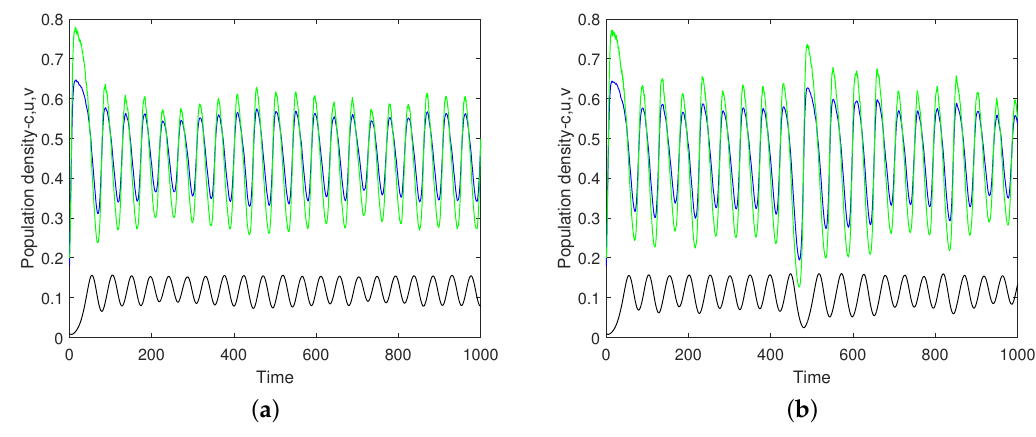
Figure 10. Oxygen concentration (blue), phytoplankton density (green) and zooplankton density (black) vs. time obtained for A D = w A = w C = 0, A Q = 2.02, c 1 Q = 0.7 and c 1 D = 0.1. The presence of noise distorts the otherwise periodical oscillations. Results shown in ( a , b ) are obtained in different simulation runs performed for the same parameters and initial conditions; hence, the apparent difference between ( a , b ) is the effect of the stochasticity.